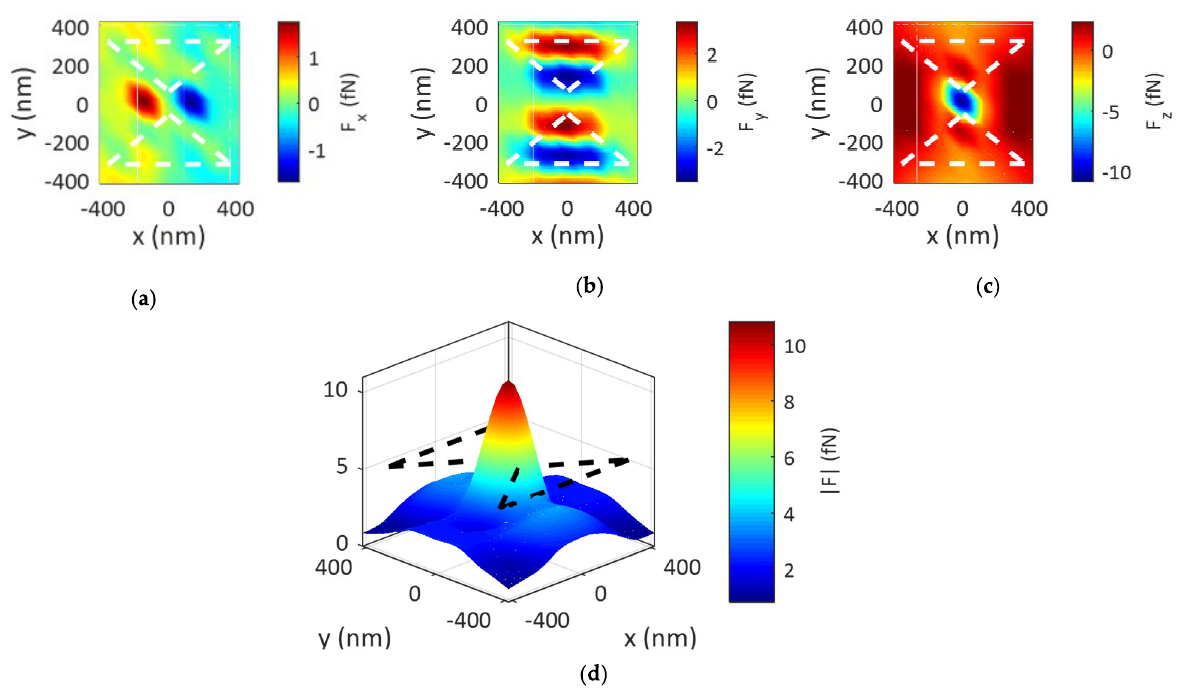
Figure 7. F x ( a ), F y ( b ), F z ( c ), and |F| ( d ) distribution within x-y plane with P norm = 6 mW/ µ m 2 and z = 275